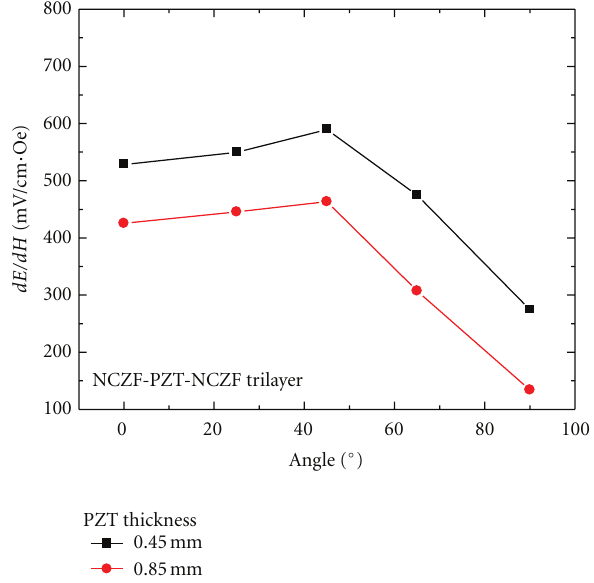
Figure 18: E ff ect of orientation on ME coe ffi cient of NCZF-[PZT- 0.1 PZN]-NCZF trilayer composite with two di ff erent [0.9 PZT-0.1 PZN] thickness.